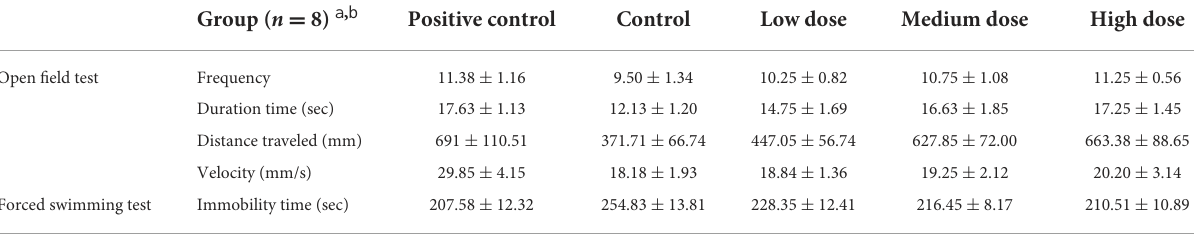
TABLE 2 Evaluation of the benefits of combined extracts in mice by the open field test (OFT) and the forced swimming test (FST).